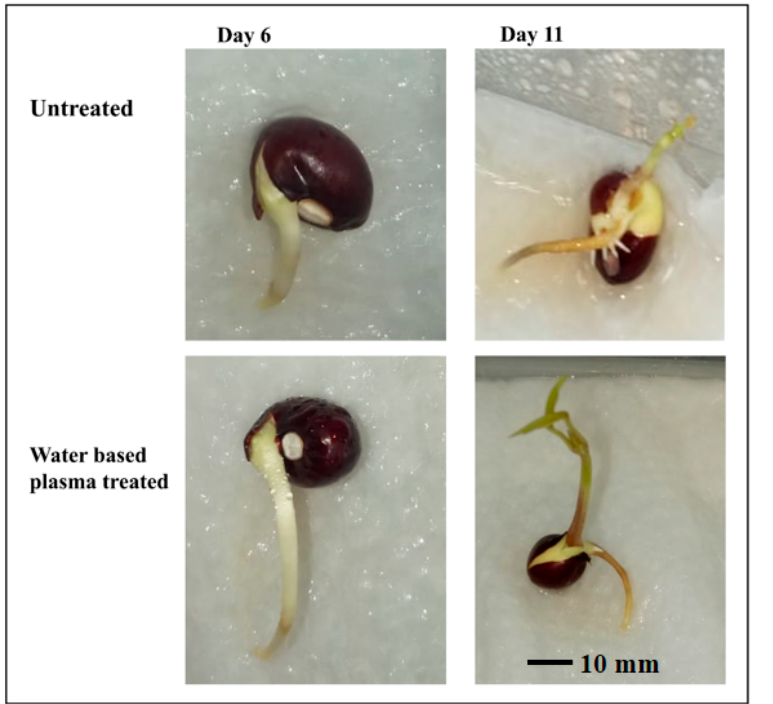
Figure 3. Photographs of the H 2 O-LPP-treated and untreated Bambara groundnut seeds 6 and 11 days after germination.